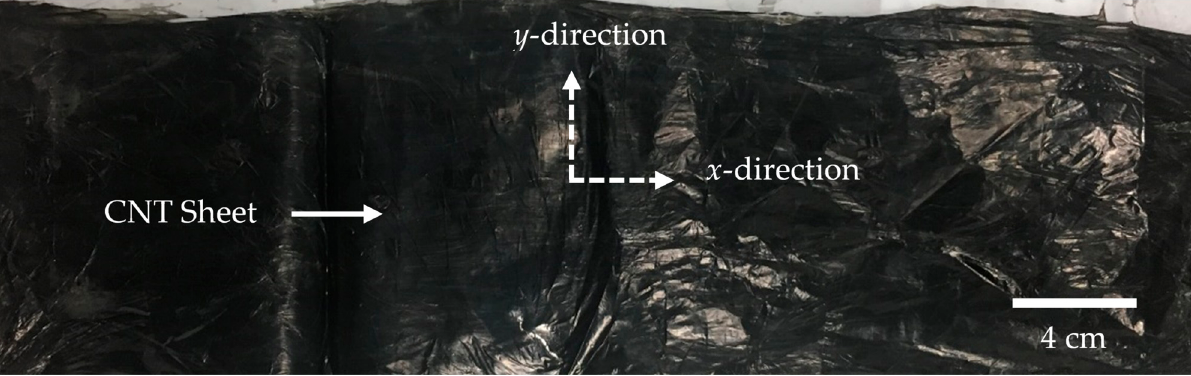
aligned in the x -direction than the y -direction. The higher alignment of the CNTs in one direction causes the macrostructure of the CNT sheet to have anisotropic properties. Analyzing the scanning electron microscope (SEM) images helped in understanding the surface morphology of the synthesized CNT sheets samples from the five different fuel types. Figure 4a–e shows the surface morphology of the CNT samples produced from Fuels I–V, respectively.